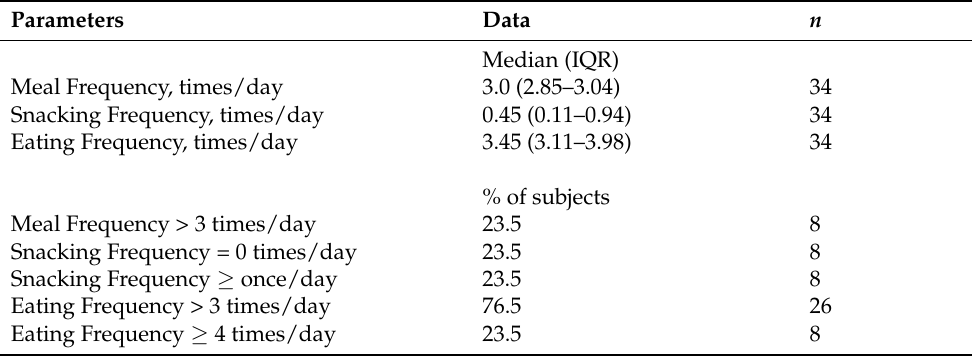
Table 2. Eating behaviors during 6 days after